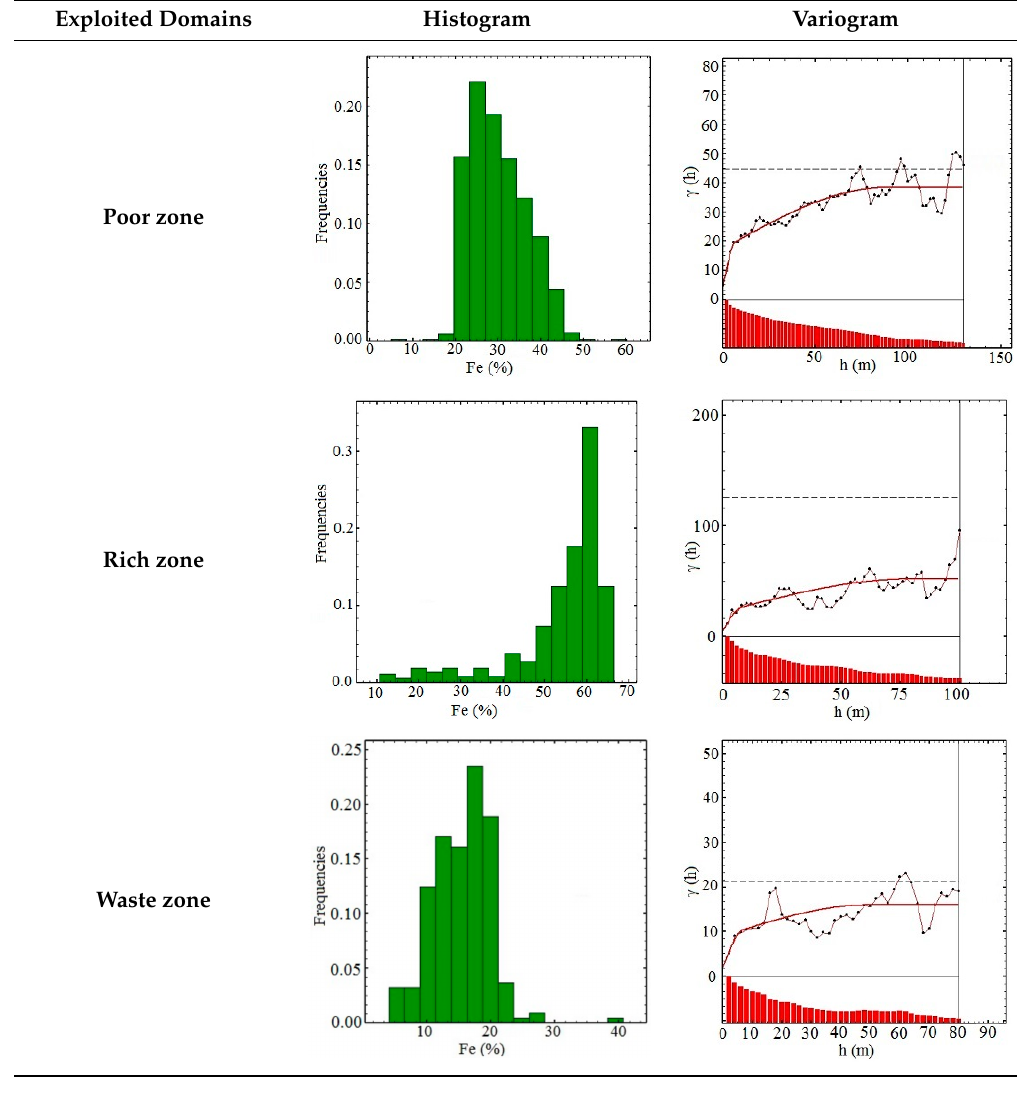
Table 3. Histogram, sample variogram (black points) and the variogram model (red line) for regularized 2.0 m samples for local models (waste, poor and rich domains).